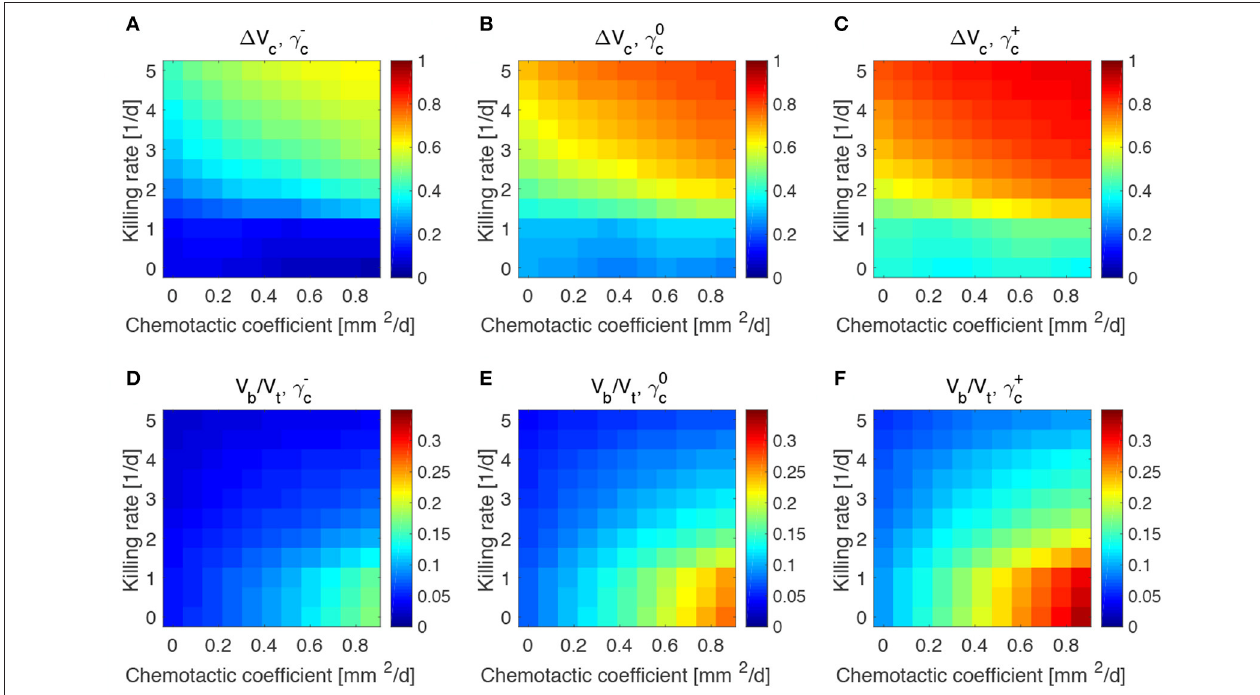
FIGURE 5 | Impact of tumor proliferation rate on tumor and bacteria volumes at the end of the simulations (day 50). Relative tumor volume change and relative bacteria volume for low (A,D) , nominal (B,E) and high (C,F) tumor cell proliferation rate.